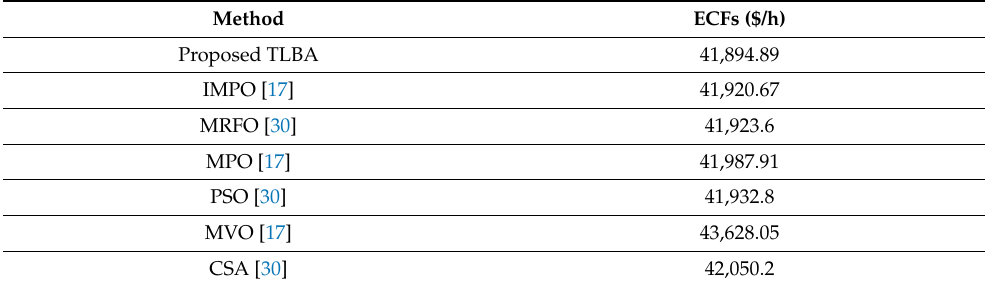
Table 8. Comparative results for the minimization of the TFCs of the IEEE 57-bus network.